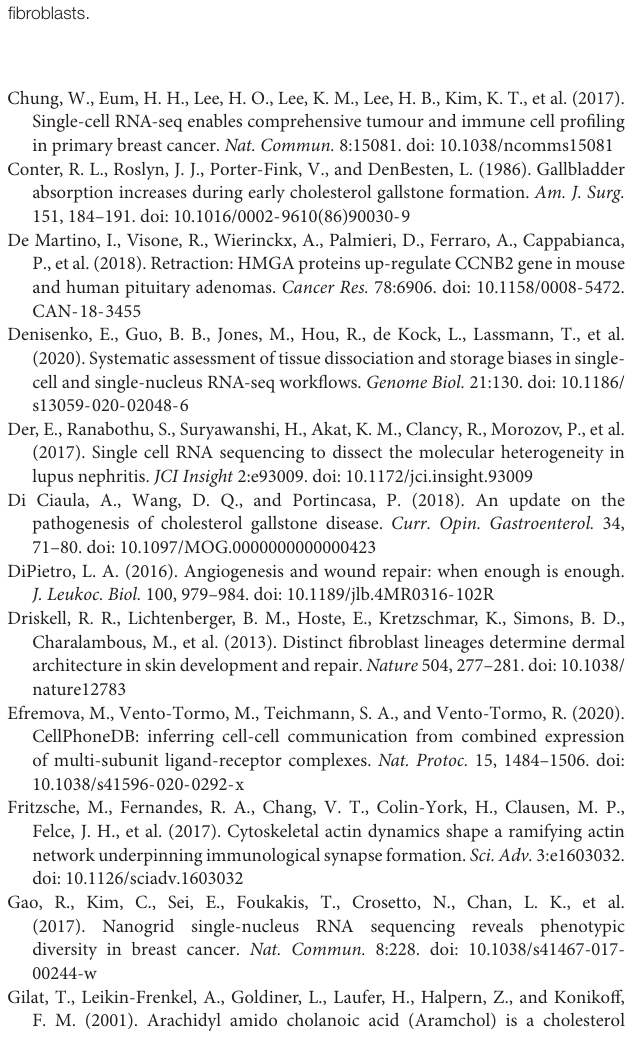
Supplementary Figure 2 | Heatmap show of markers in each cell cluster of gallbladder cells by scRNA-seq analysis. Supplementary Figure 3 | t-SNE plot highlighting the sub-clusters of epithelial cells according to representative markers. The epithelial cells were enriched in makers for mucin secretion (mucin, Muc3 , Muc4 ) and water channel (aquaporin 1, Aqp1 ). Supplementary Figure 4 | Violin plots showing the expression level of representative markers across different cluster of cells. (A) Proliferative cells (Cluster 13), Cdca3 ; (B) Endothelial cells (Cluster 14), Pecam1 ; (C) Macrophages (Cluster 20), C1qa ; (D) Fibroblast (Cluster 21), Dcn ; (E) Smooth muscle cells (Cluster 19), Acta2 ; (F) Cluster 22, Rgs13 . Supplementary Figure 5 | Violin plots showing the expression level of representative markers across the different sub-clusters of endothelial cells. Supplementary Figure 6 | t-SNE plot highlighting the sub-clusters of endothelial according to representative markers. Vegfr1 , 2, and 3 were differently expressed in EC clusters. Supplementary Figure 7 | Violin plots showing the expression level of representative markers across the different sub-clusters of immune cells. Supplementary Figure 8 | Violin plots showing the expression level of representative markers across the different sub-clusters of